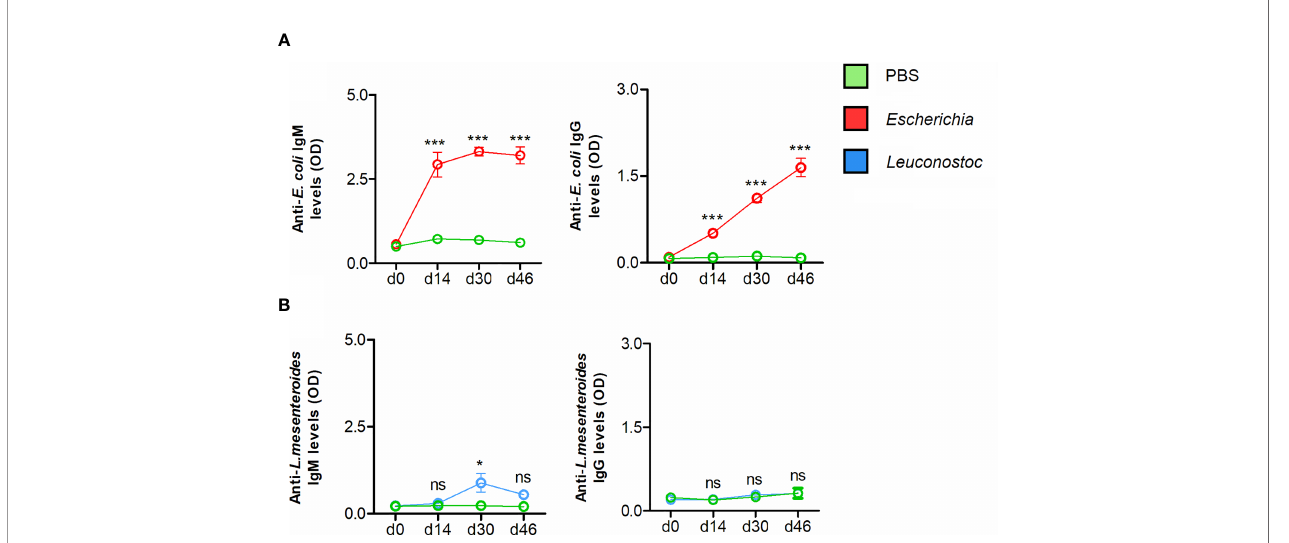
FIGURE 5 | Antibody response of mice vaccinated with live E. coli or L. mesenteroides. The levels of IgM and IgG speci fi c to (A) E. coli and (B) L. mesenteroides proteins were measured by semi-quantitative ELISA in sera of mice immunized with E. coli (red) and L. mesenteroides (blue), respectively. Antibody levels of bacteria- immunized mice were compared with those of mock-immunized (green, PBS) mice. Means and standard error values are shown. Results were compared by two- way ANOVA with Bonferroni test applied for comparisons between control and immunized mice. (* p < 0.05, *** p < 0.0001; ns-not signi fi cant; 1 experiment, n = 12 mice and three technical replicates per